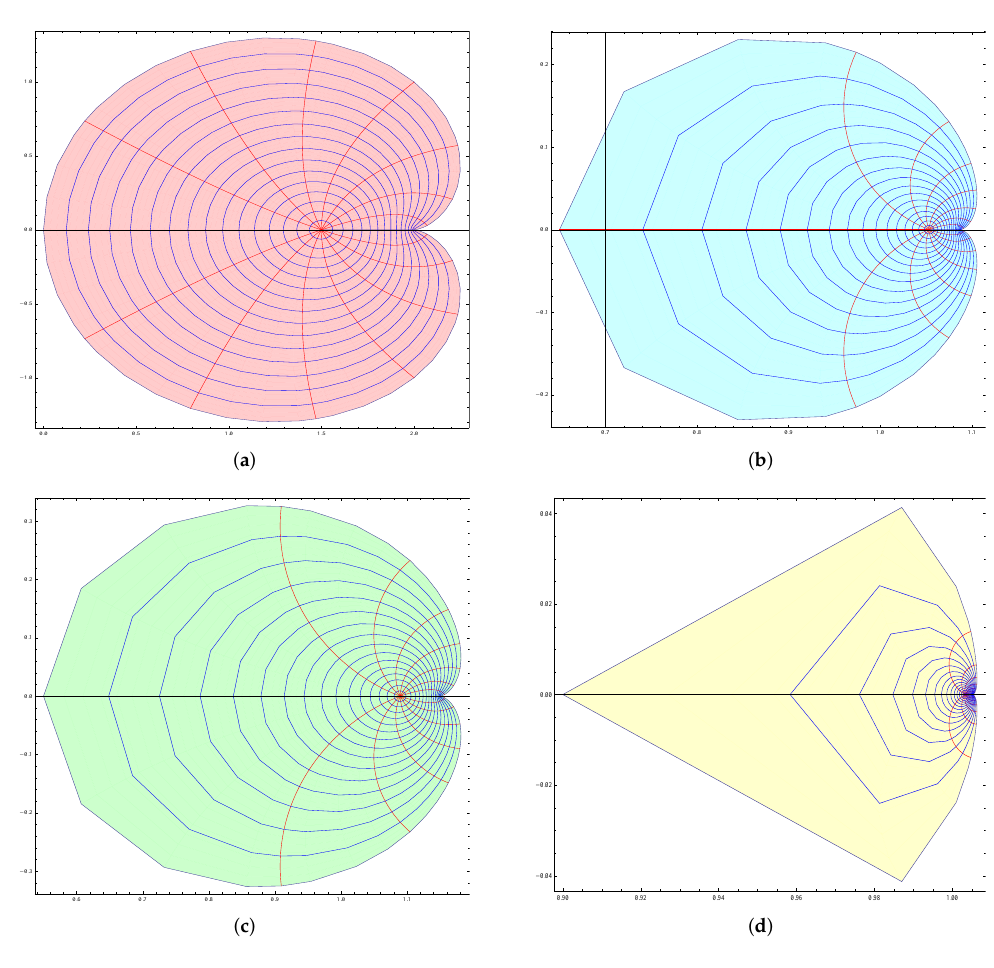
Figure 1. Impact of ℵ ( p ; F , G ; α ; ψ ; z ) on the conic region ψ ( z ) = 3 of E under the transformation ψ ( z ) = 3 mation ℵ ( 1; 0, − 0.3; 0.9; ψ ; z ) if ψ ( z ) = 3